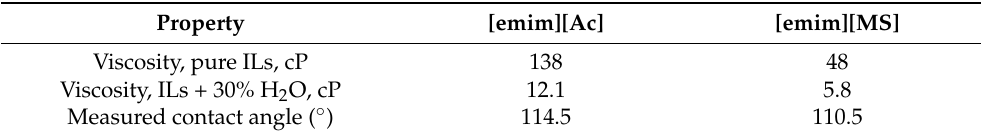
Table 4. Viscosity of [emim][Ac] and [emim][MS] and contact angle measured between the mem- brane and the ILs.